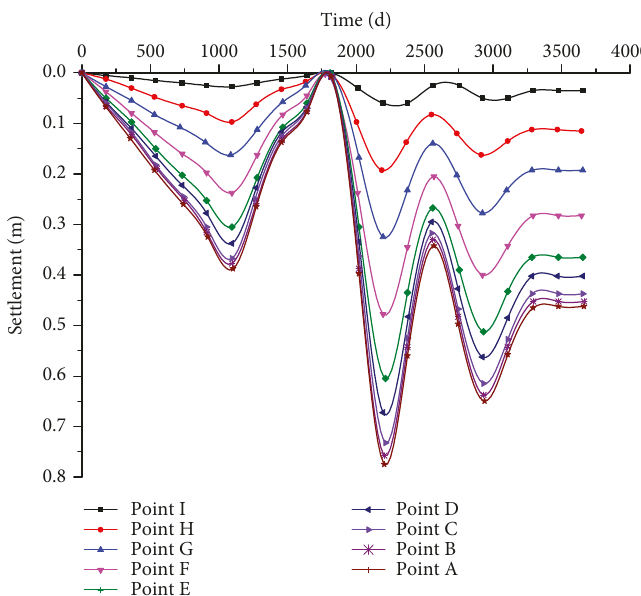
Figure 14: Ground settlement changing with time in case Π -03.